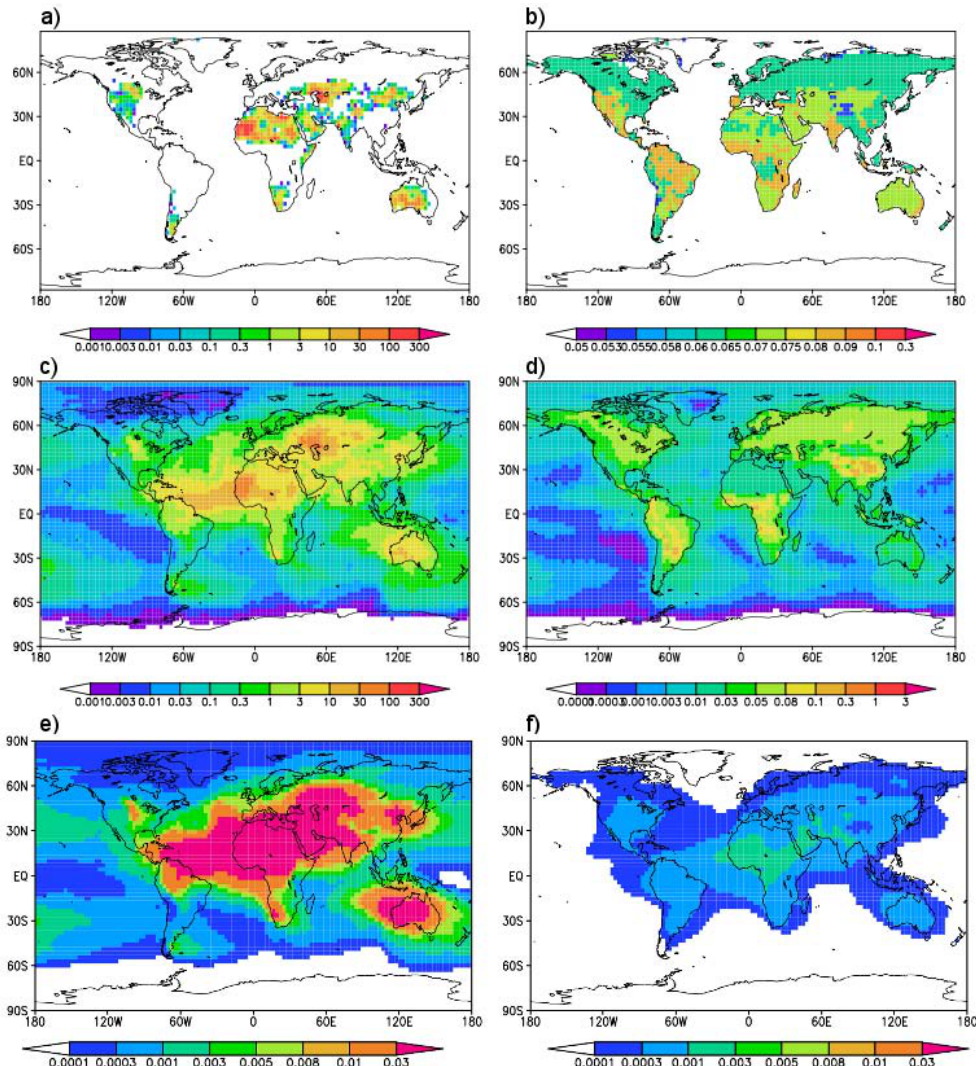
Fig. 4. Modelled (BT10, see Table 1 for description) global annual means of emission, deposition and burden of bacteria and mineral dust. (e) dust burden [g m − 2 ] (f) bacteria burden [g m − 2